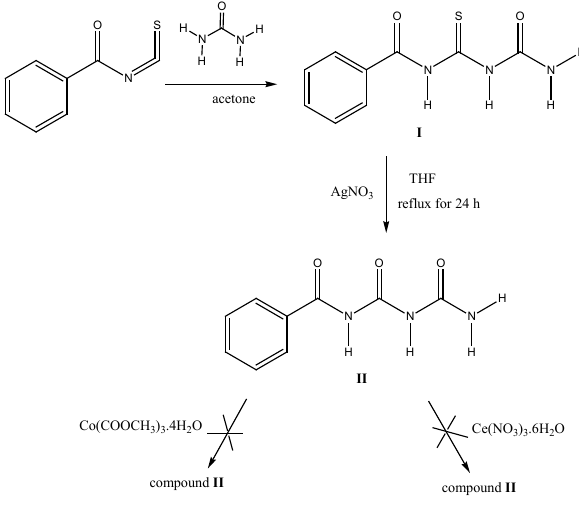
Scheme 5: Synthesis of compounds I and II